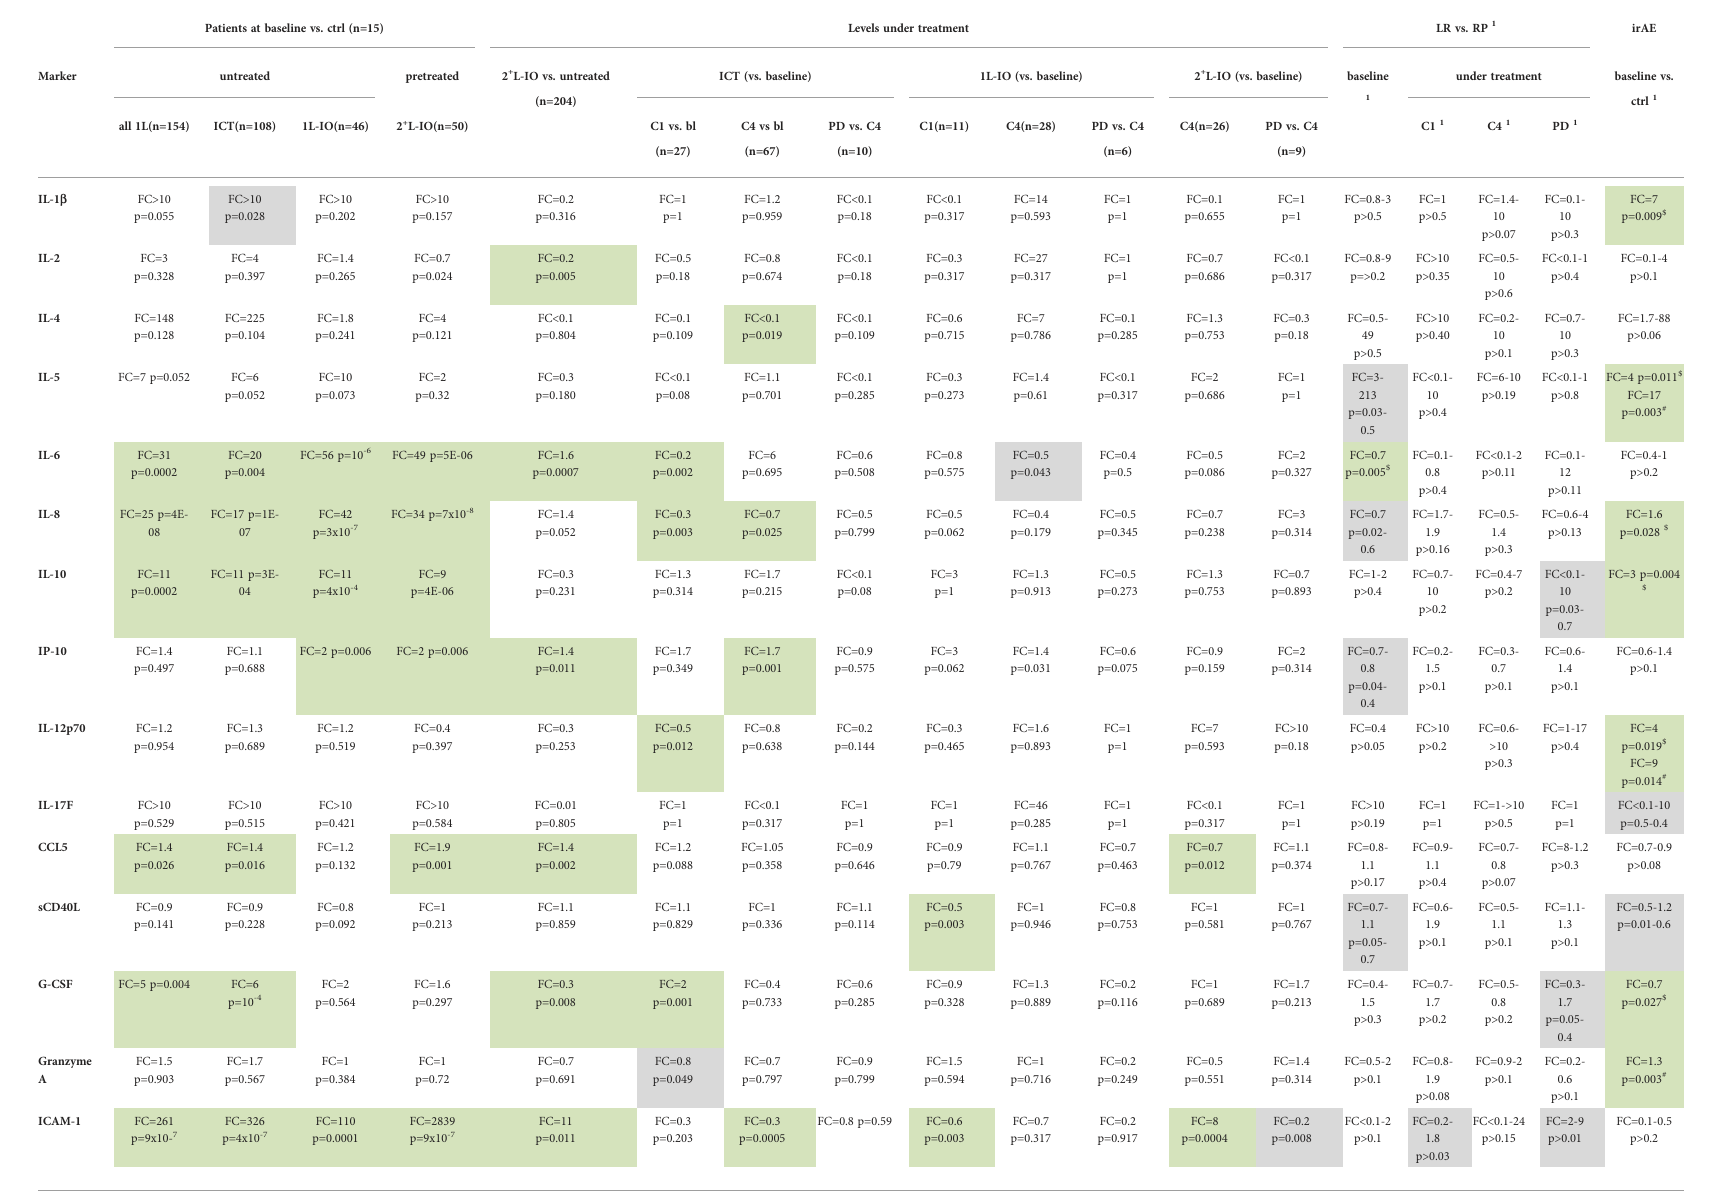
TABLE 2 Pro fi le of blood markers in study patients and healthy controls. Patients at baselinevs.